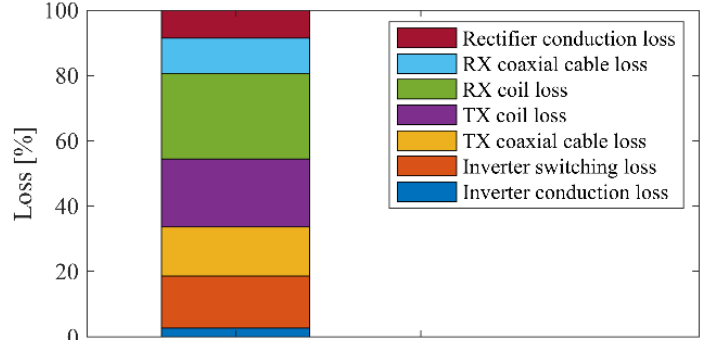
Figure 18. Estimated percentage losses of the developed system.